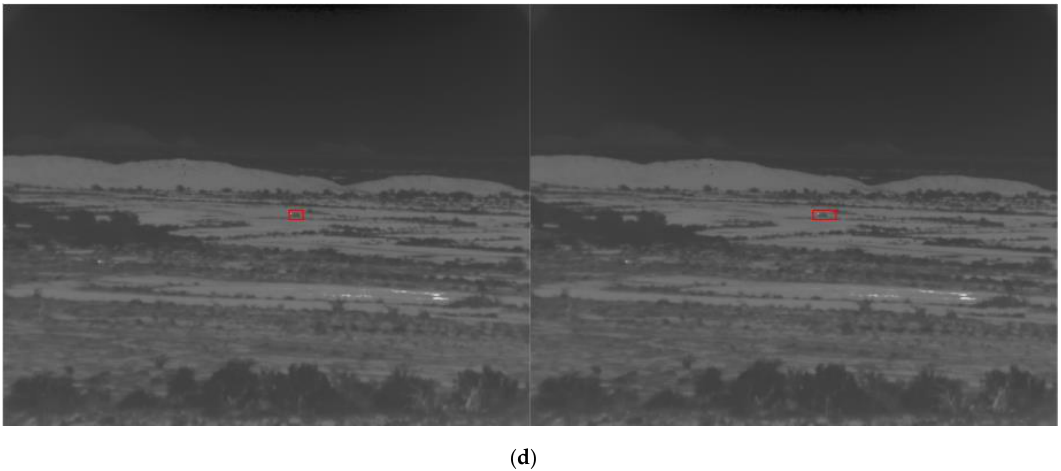
Figure 11. Comparison of four approaches across 2 different frames in a 3500 m video. ( a ) Total Variation with L1 constraint (TV-L1) in proposed Python Workflow with SORT (left) and TV-L1 in Alternative Workflow with rules (right); ( b ) Brox in proposed Python Workflow with SORT (left) and Brox in Alternative Workflow with Rules (right); ( c ) TV-L1 in proposed Python Workflow with SORT (left) and TV-L1 in Alternative Workflow with Rules (right); ( d ) Brox in proposed Python Workflow with SORT (left) and Brox in Alternative Workflow with Rules (right).